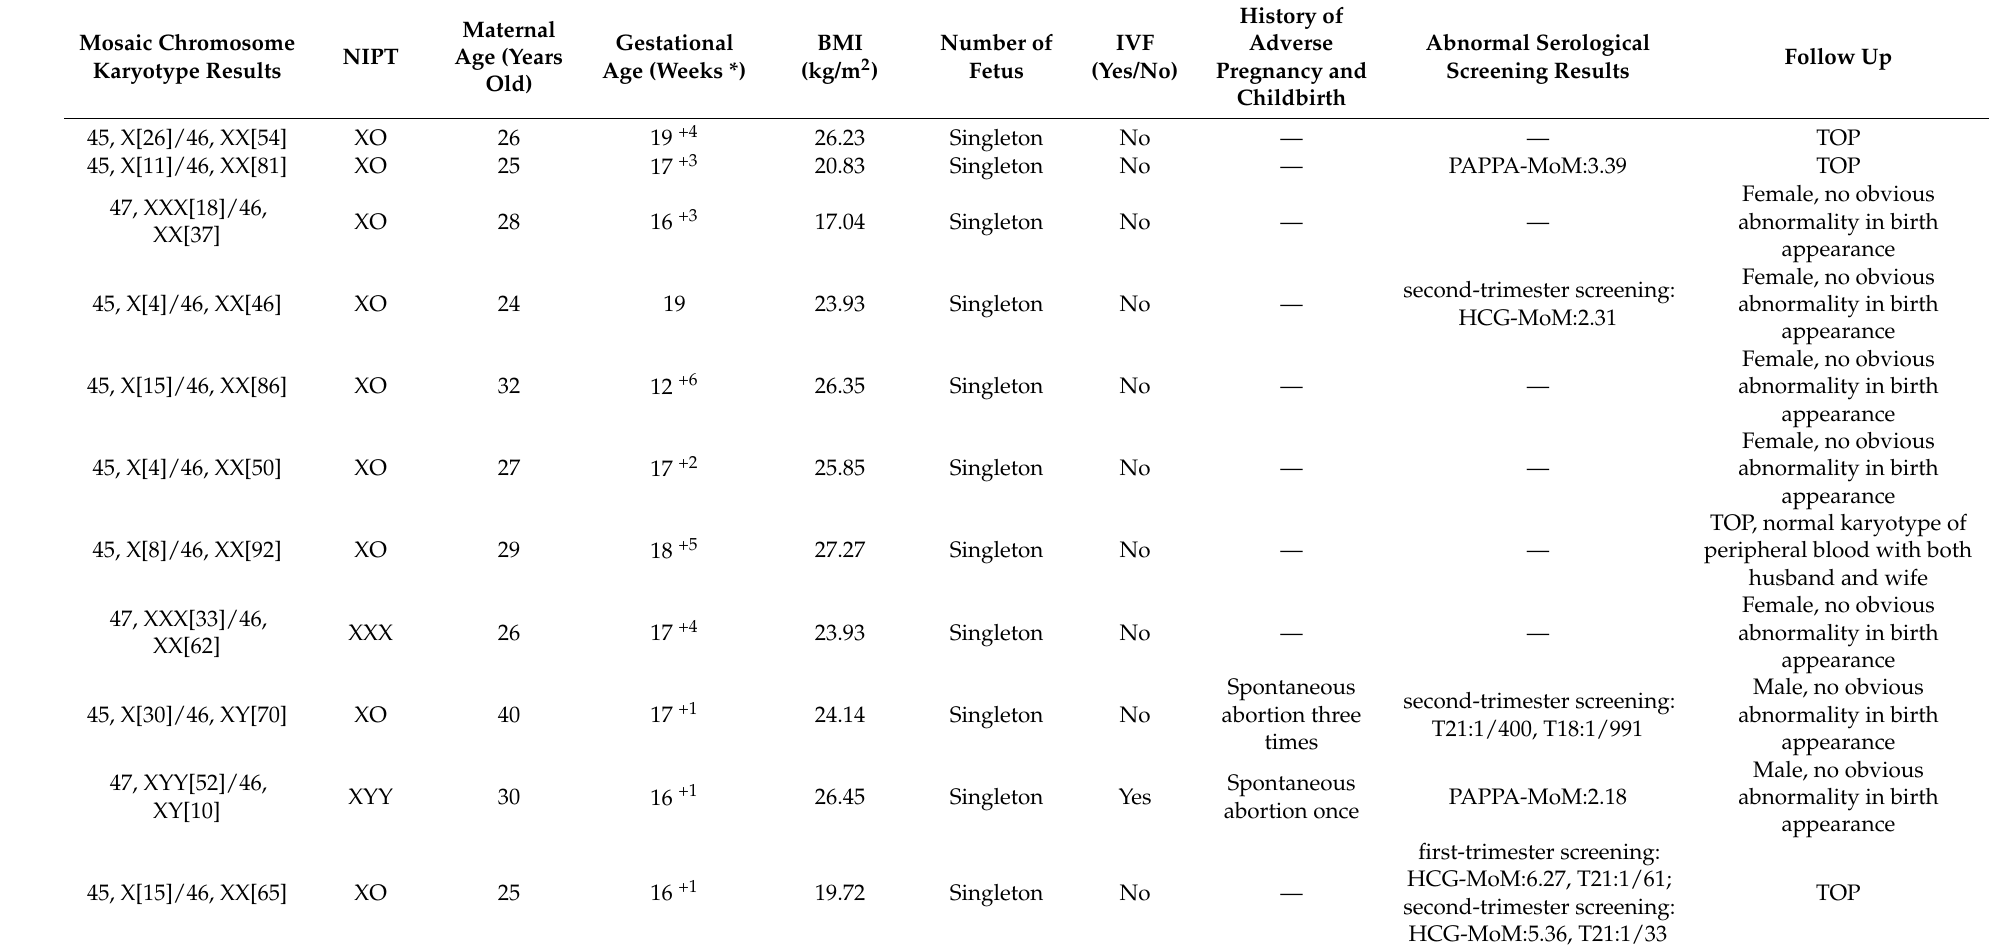
Table 4. Basic characteristics and follow-up of pregnant women with fetal mosaic chromosome karyotype results.